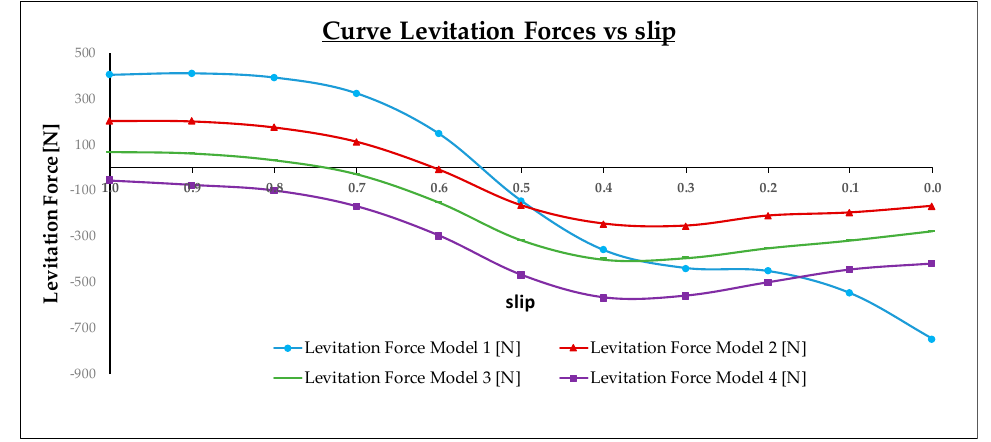
Figure 31. Levitation force versus slips.